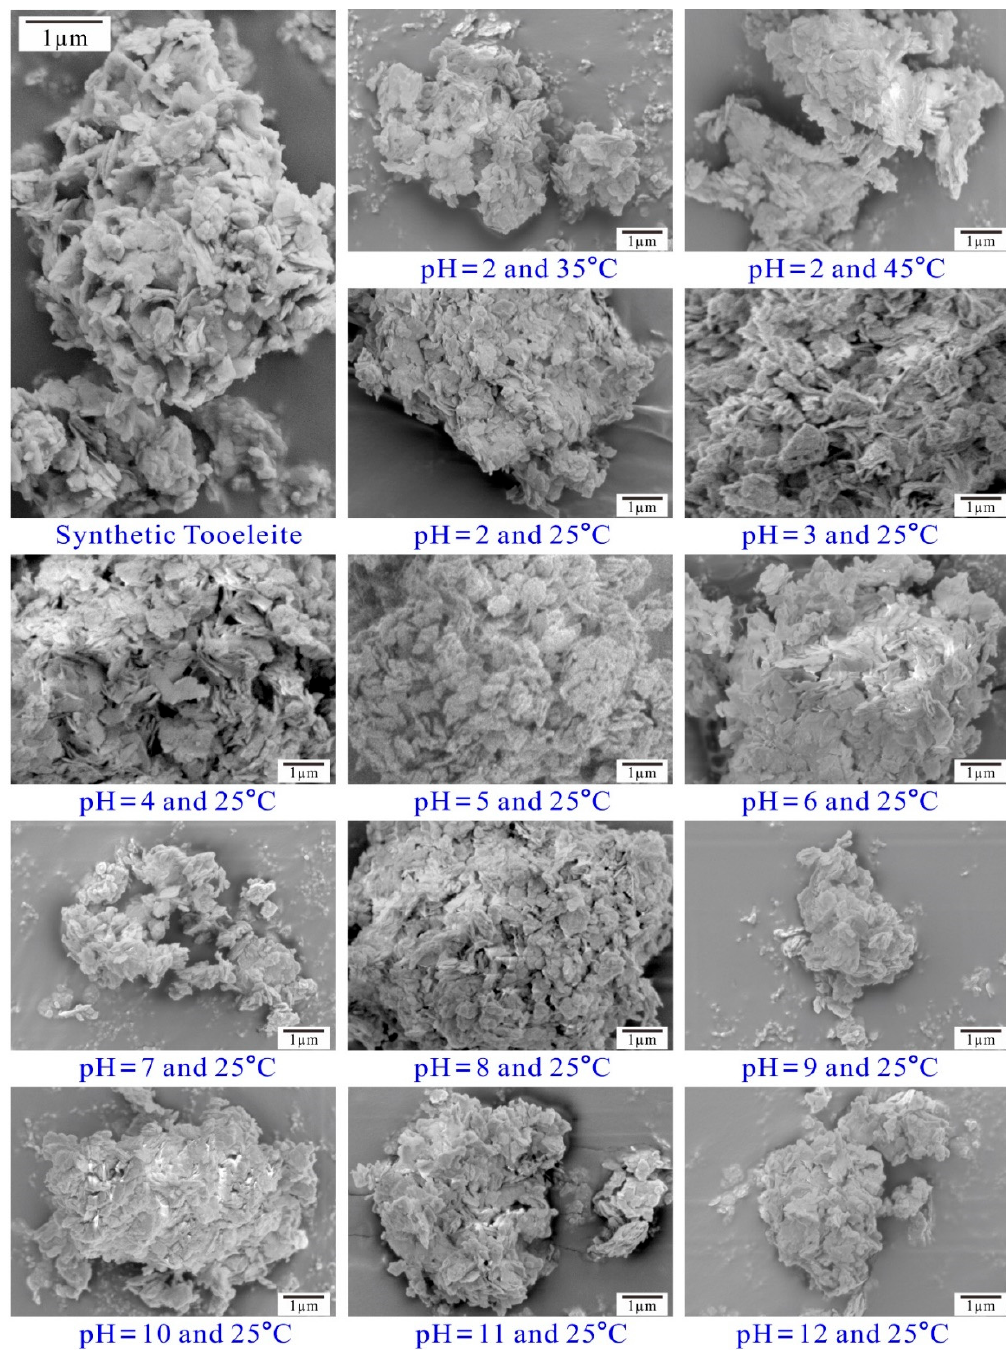
Figure 3. FE-SEM images of the synthetic tooeleite before and after dissolution for 330 d.